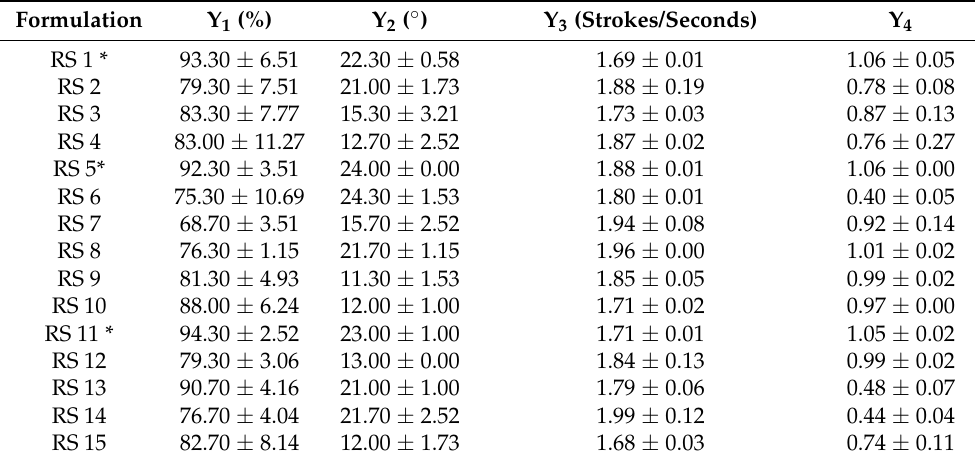
Table 4. Response parameters generated for the fifteen experimental design formulations.